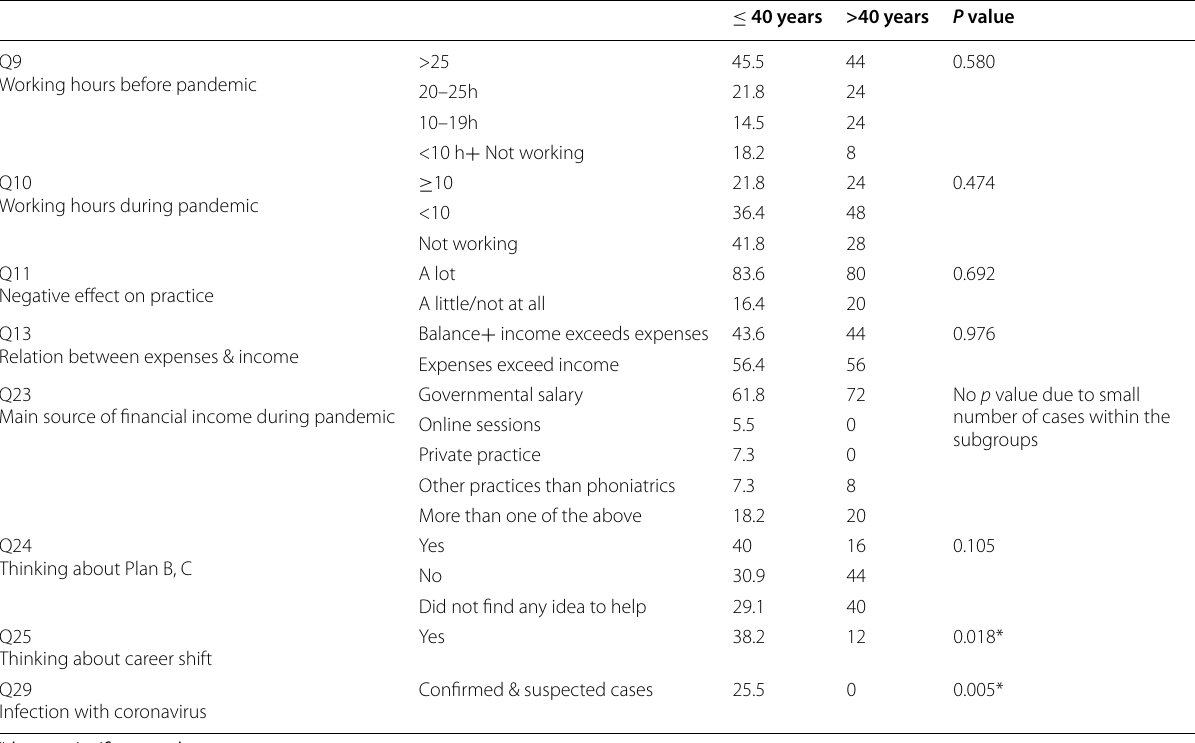
Table 4 Comparison between younger and older age groups regarding the percentage of their responses to some economic aspects